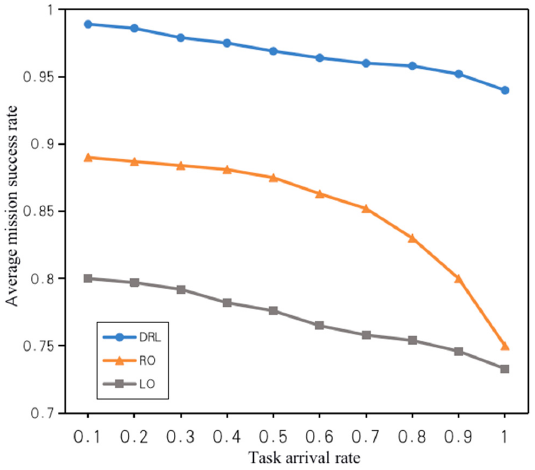
Figure 2. Average mission success rate.